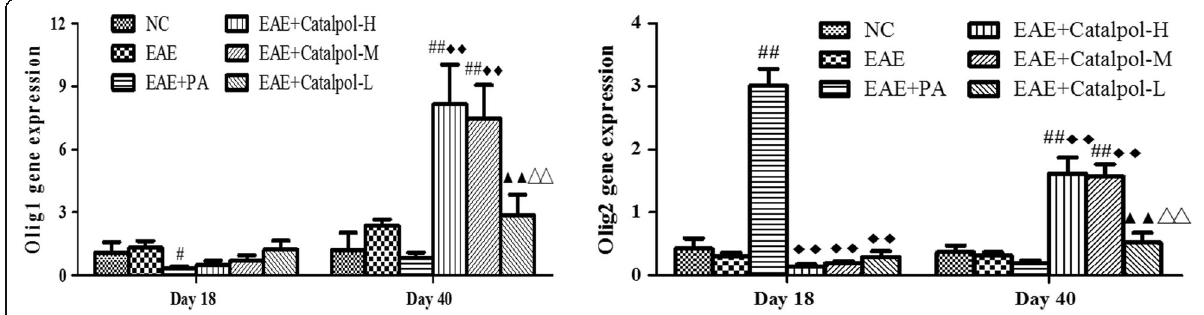
Fig. 11 The gene expressions of Olig1 and Olig2 in the brains of mice on Day 18 and 40 in NC ( n =5), EAE ( n =5), EAE+PA ( n =5), EAE+Catalpol – H ( n =5), M ( n =5) and L ( n =5) mice, respectively. Note: # P <0.05, ## P <0.01 vs. EAE; ◆◆ P <0.01 vs. EAE+ PA; ▲▲ P <0.01 vs. EAE+Catalpol – H, △△ P